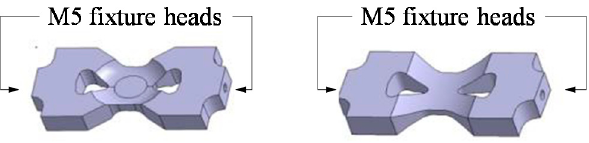
Figure 20. Preliminary designs of UFT twin-teardrop specimens (spherical and cylindrical) [98].